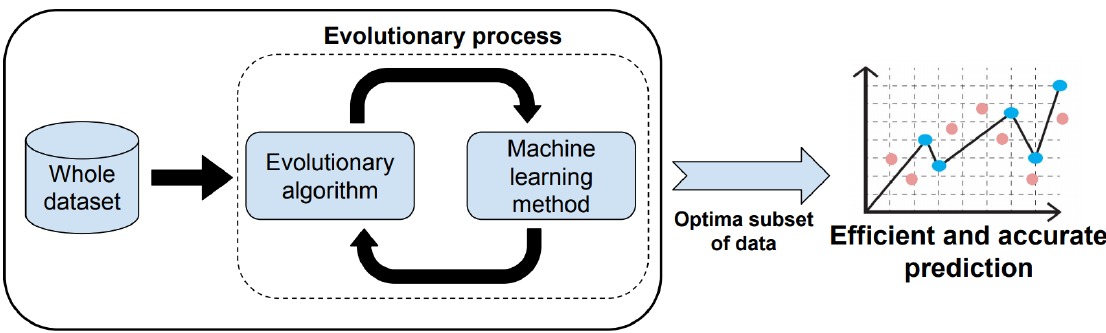
Figure 2. BiPred